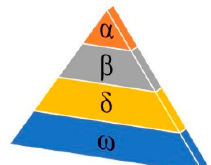
Figure 10. Grey wolf social hierarchy.